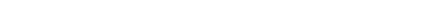
Figure 8 . Signal acceptance ( A ) for the pp in table 1, varying transverse momenta cuts in the [0 ; 20] GeV interval. We de(cid:12)ne ‘ 1 as the leading lepton, p ‘ 1 > p ‘ 2 . The diamond marks the cuts we used following ATLAS dimuon analysis T T